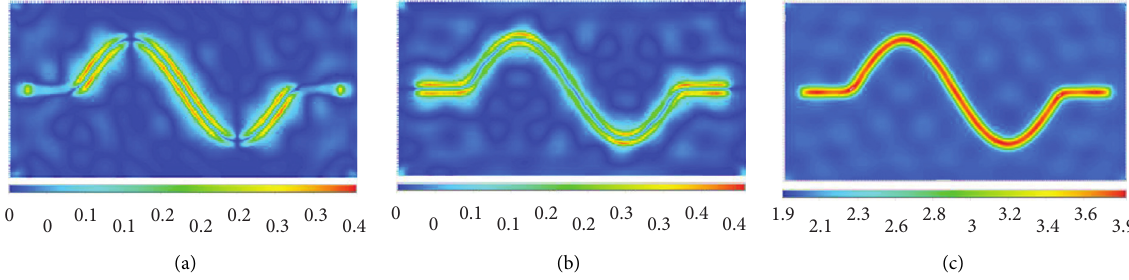
Figure 41: P wave incident ( C